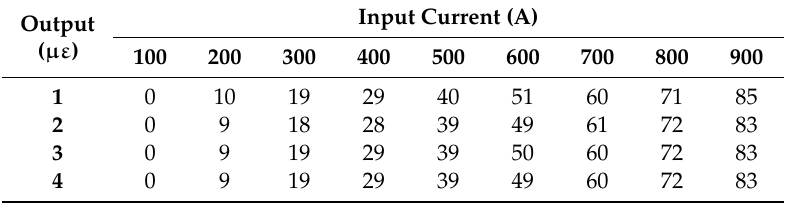
Table 2. Sample data for the repeatability test.